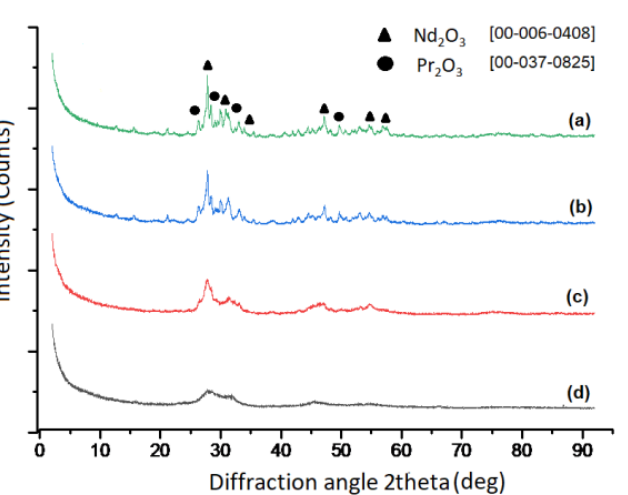
Figure 7. XRD analysis of RE-oxide powders synthesized with varying reaction temperatures between 700 °C and 1000 °C.